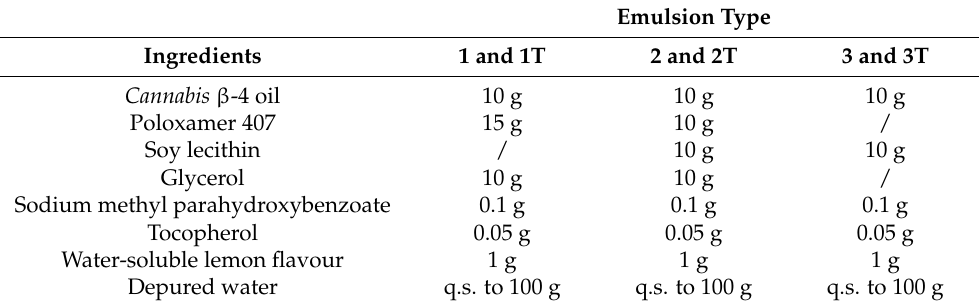
Table 1. Emulsions